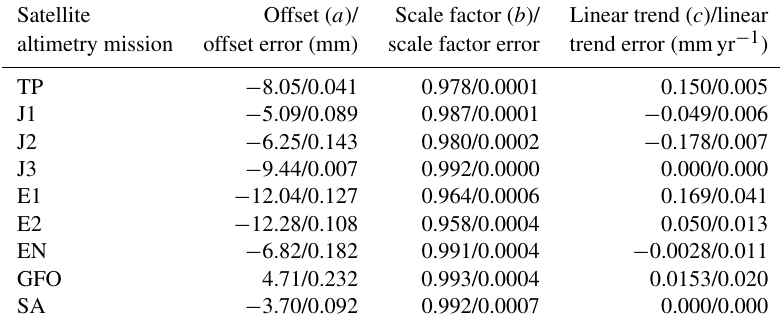
Table 2. Calibration parameters (offset, scale factor and linear trend) obtained for all RA missions with an on-board MWR included in the GPD + database (Fernandes et al., 2019). For the Jason-3 (J3) and SARAL (SA) missions, no parameter for the linear trend has been computed due to the short length of their datasets. For an explanation of the mission codes, please refer to Table